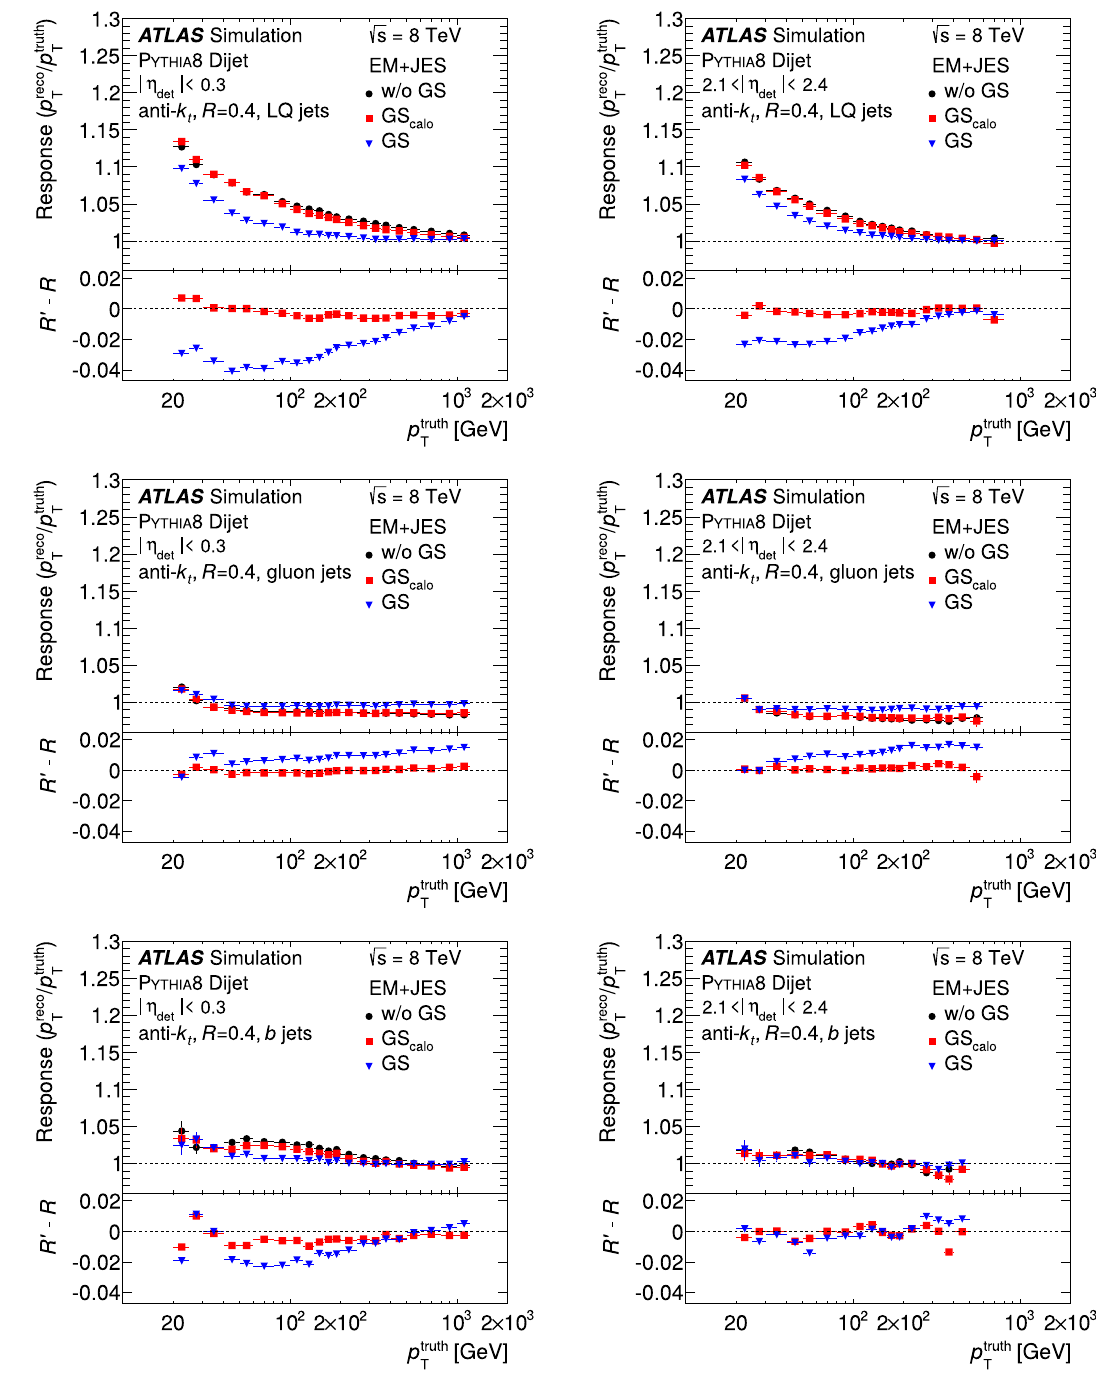
corrections only (squares) and including all the GS corrections (trian- gles) are shown. The lower box of each plot shows the impact on the jet response, subtracting the response before the GS corrections ( R ) from the response after applying the GS corrections ( R (cid:16)